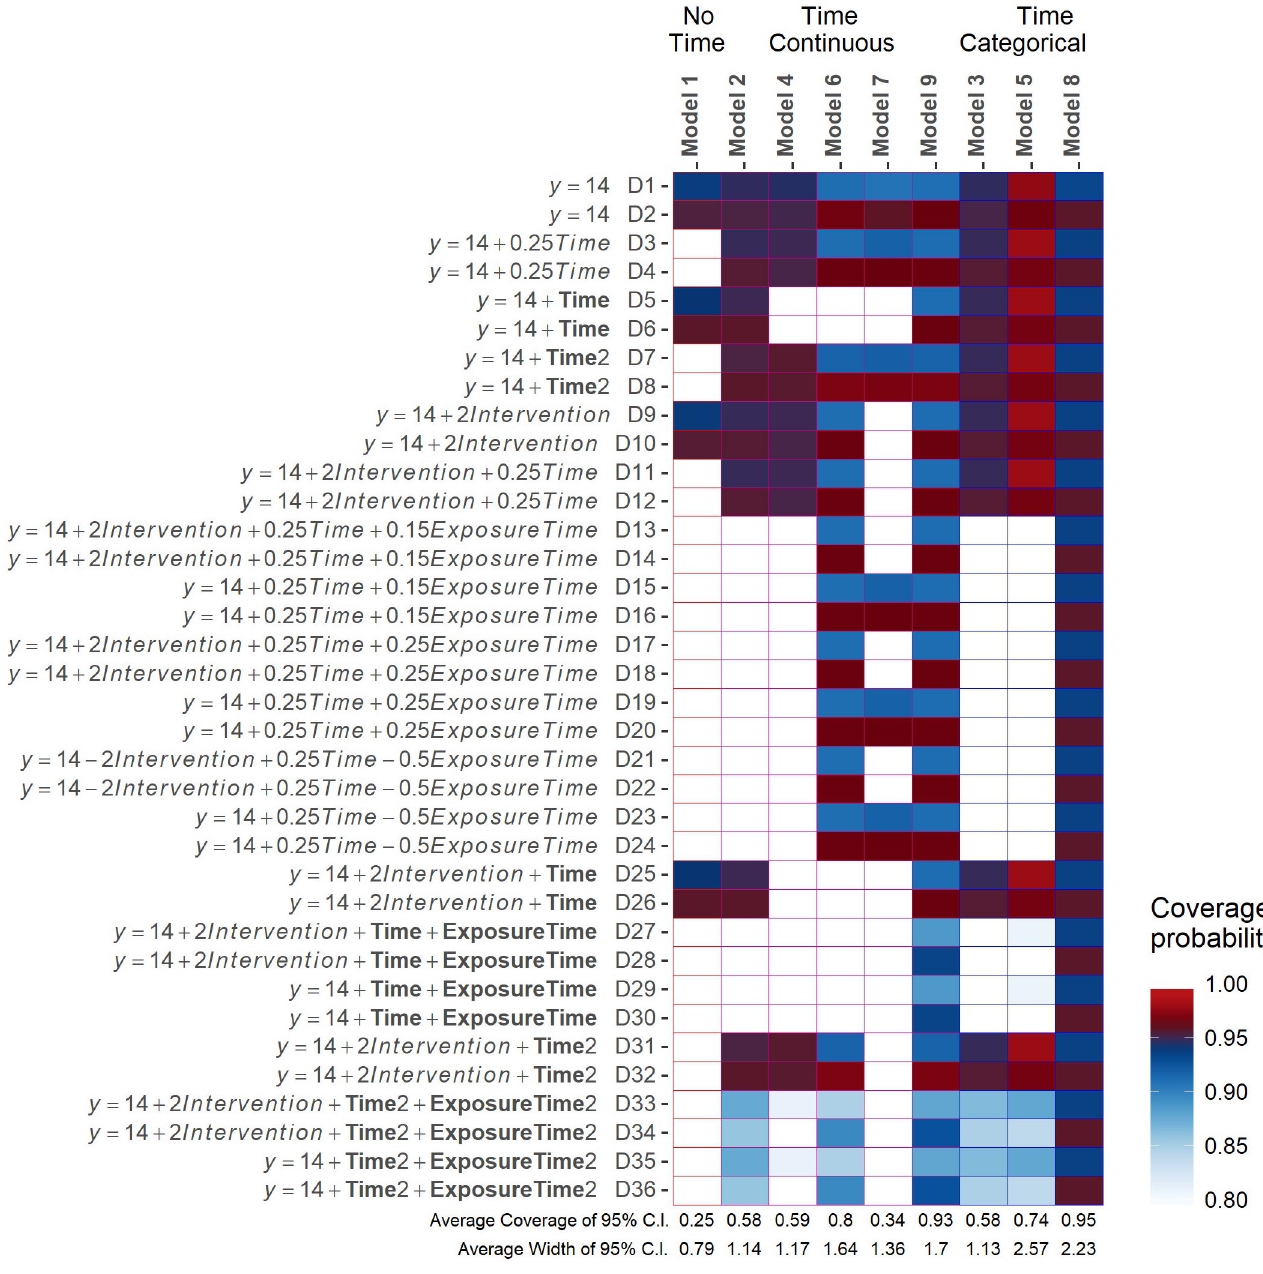
Fig 5. The heat map shows the coverage probability of the intervention effect at six months exposure for the nine fitted models with CS correlation structure. The heat map was very similar when the AR(1) structure was specified and for the time-averaged intervention effect. Values at the bottom of each column show the average coverage probability for each fitted model and the average width of the confidence interval for the intervention effect. Odd-numbered scenarios are simulated with ρ = -0.5 and even-numbered scenarios have ρ =